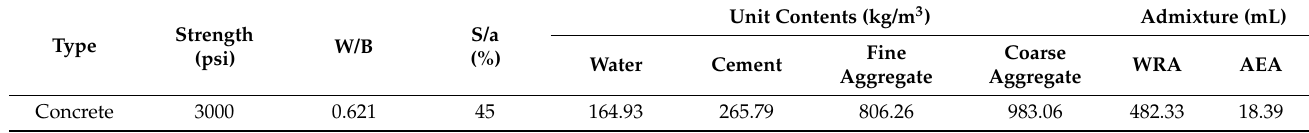
Table 1. Mixing details of nuclear power plant